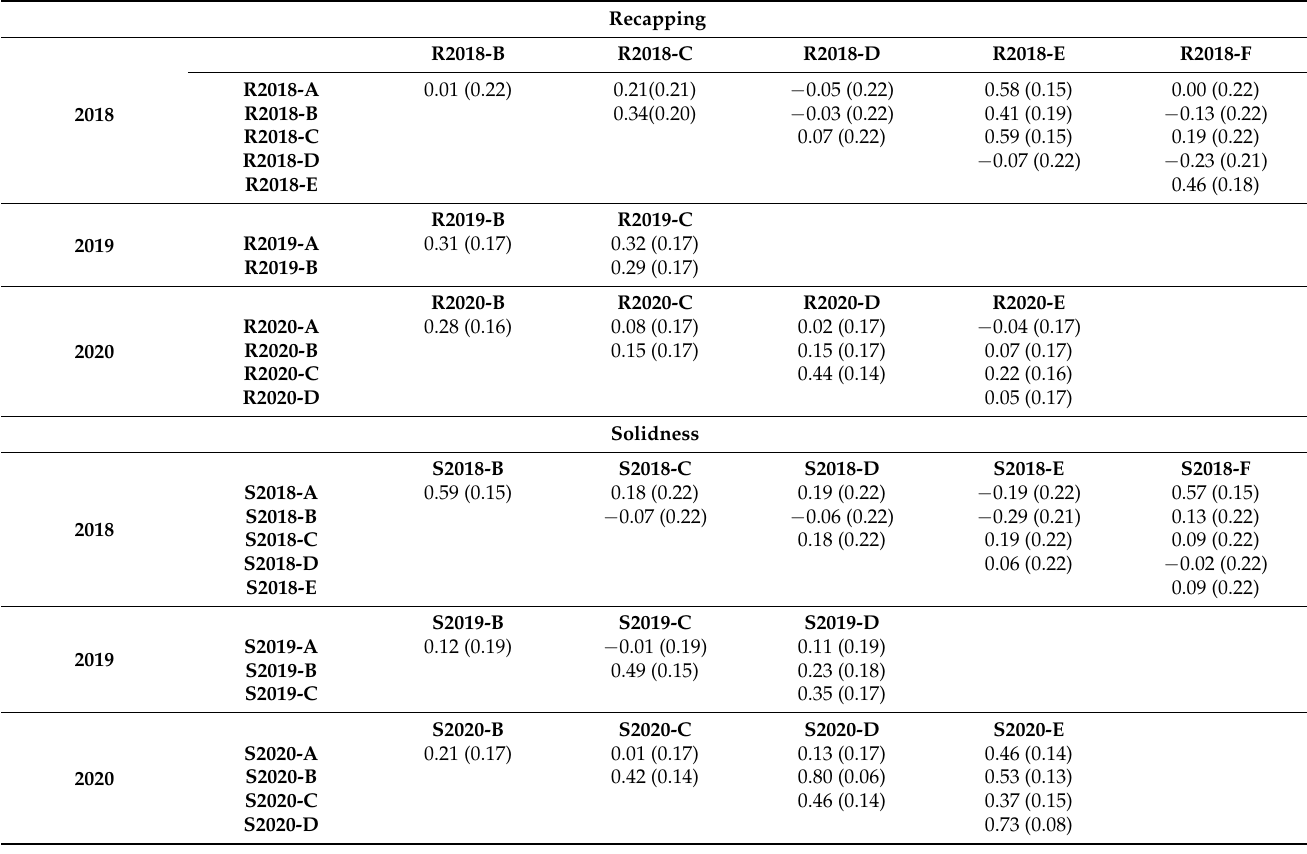
Table 2. Repeatability values and associated standard errors (between brackets) for ‘Recapping’ and ‘Solidness’ for measure- ments (repetitions A to F) performed during years 2018, 2019, and